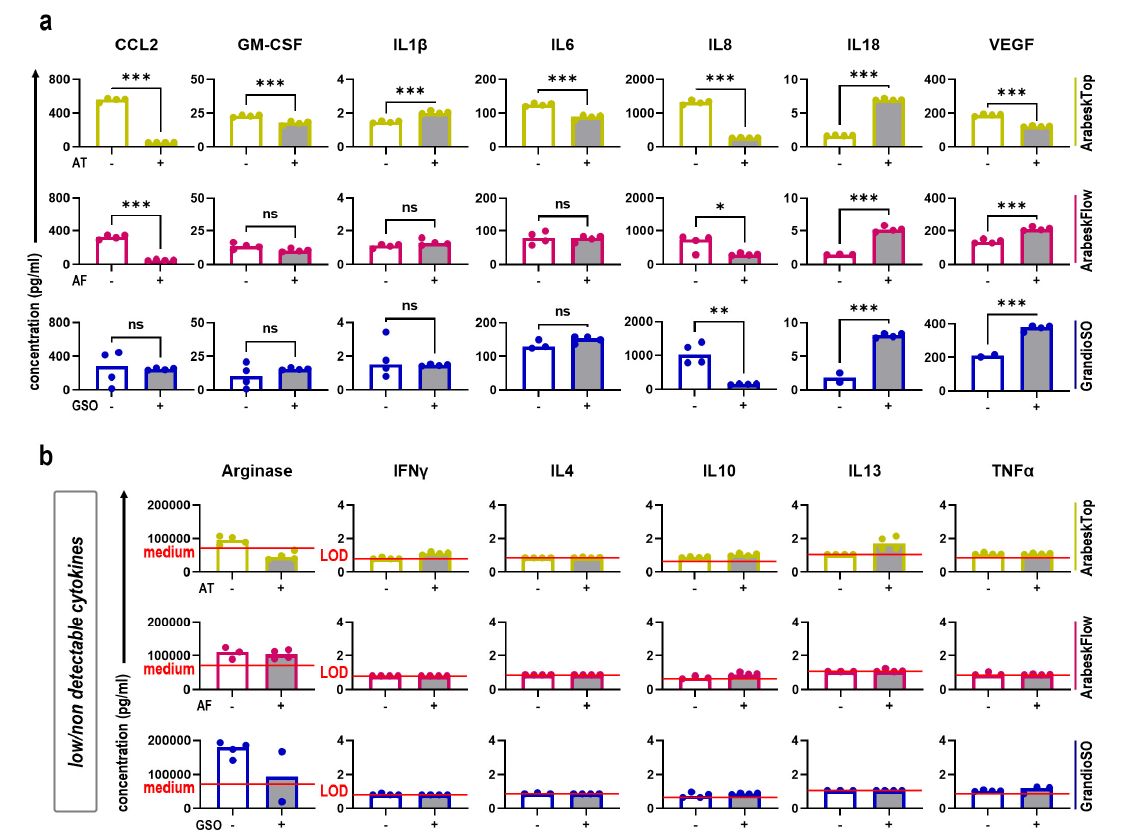
Figure 4. Secretion profiles of cells cultured in presence or absence of composite chips. ( a , b ) good to highly abundant ( a ) and modest to low abundant ( b ) absolute concentrations of 13 different cytokines and chemokines in cellular supernatants 24 h after onset of human HaCaT keratinocytes cultured either on untreated composite chips or in the absence of composite chips in tissue culture- treated 96-well plates. Data are mean of four technical replicates pooled from six independent experiments with three technical replicates each. Statistical analysis was performed using t -test.